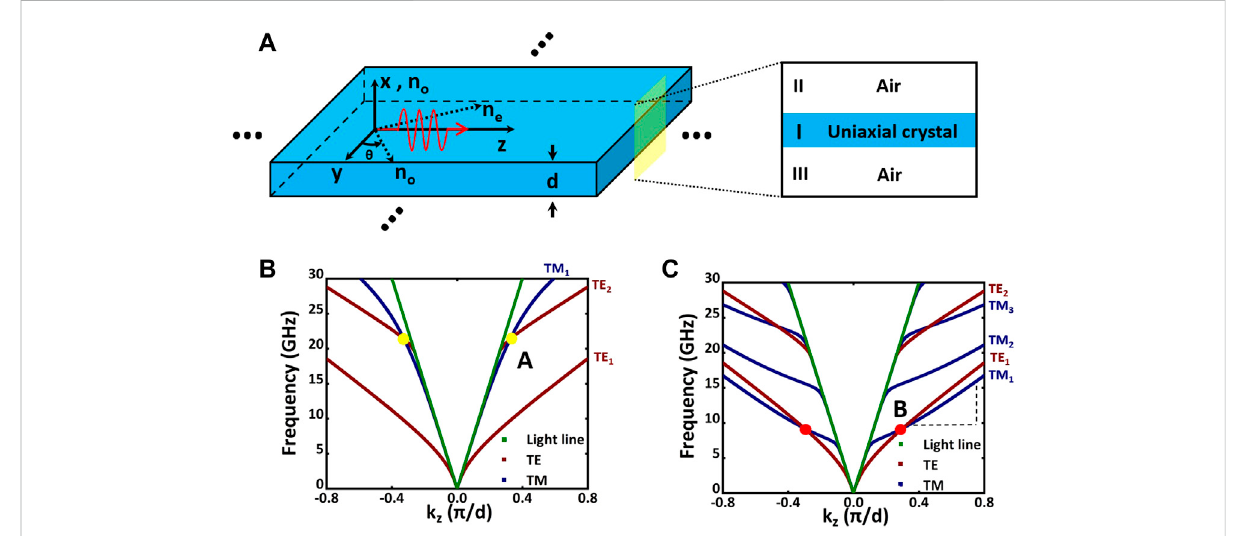
FIGURE 2 (A) The schematic picture of the anisotropic dielectric slab waveguide, where ( x , y , z ) is the coordinate system for the slab; ( n o , n o , n e ) is the dielectric principal axes for the anisotropic permittivity. The red arrow represents the propagation direction of electromagnetic wave. The panel in the right shows the three layers structure in our system. The slab thickness d = 2 mm. (B) Dispersion diagram of TE and TM modes in the negatively uniaxial case when ε z (cid:1) 4 ε 0 . The degenerate points are marked with yellow dots. (C) Dispersion diagram of TE and TM modes in the positively uniaxialcasewhen ε z (cid:1) 100 ε 0 .Thedegeneratepointsthatwewillinvestigateindetailsaremarkedwithreddots.Thevelocityoreffectiveindexofthe fi rst-order modes (TM B is approximated by the slope estimation Δ ω / Δ k z , as depicted by the right-angled dash 1 and TE 1 ) near the point